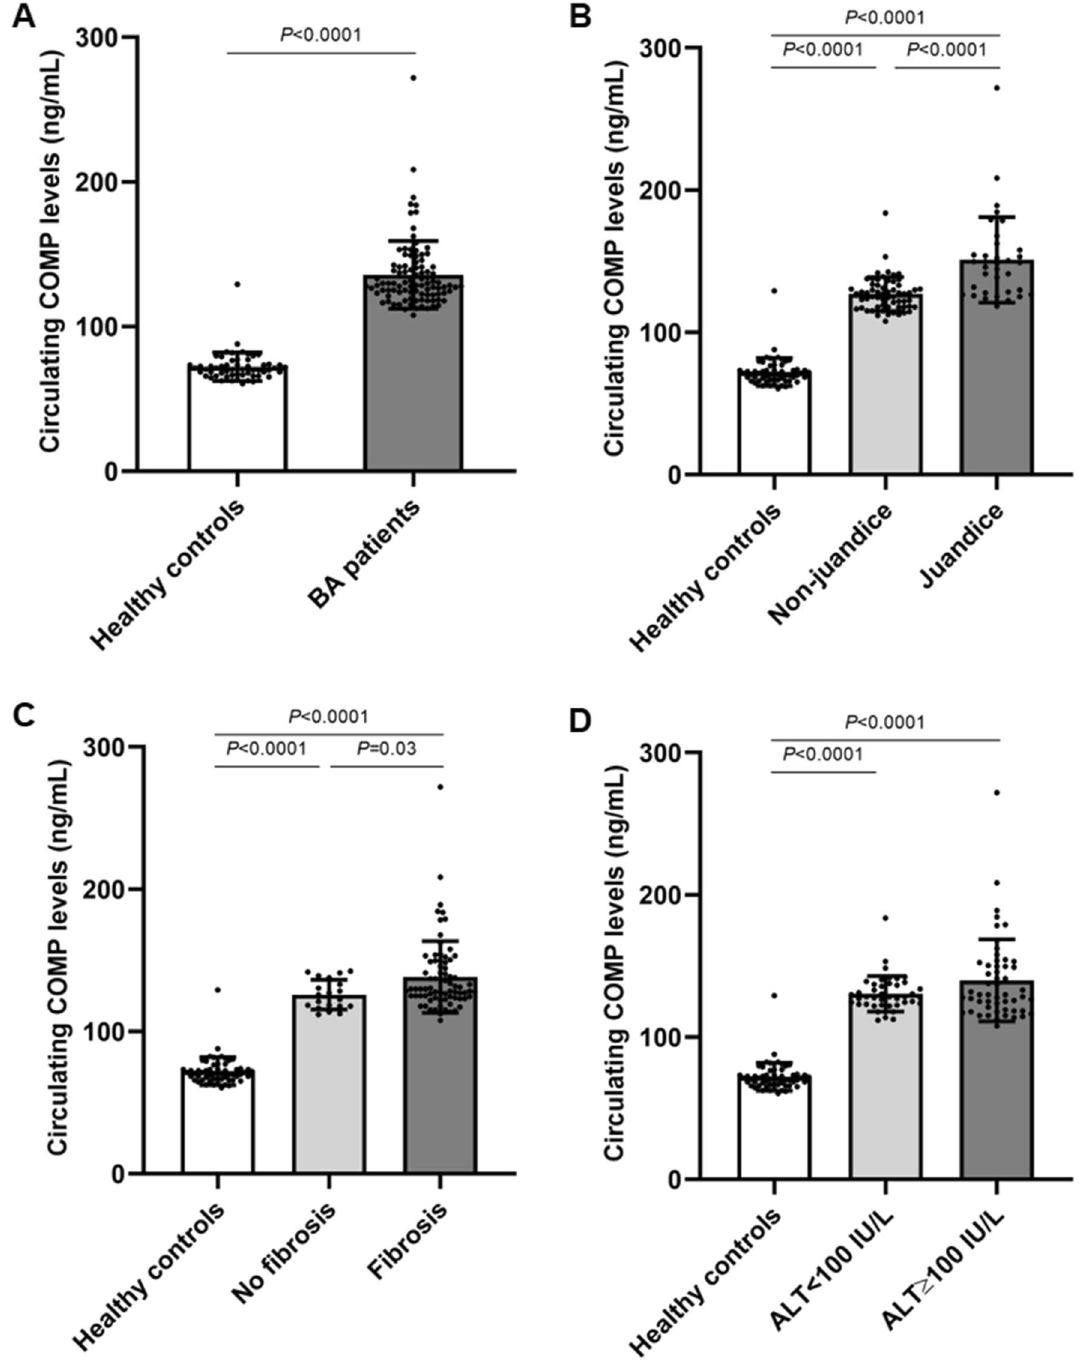
Figure 1. Circulating COMP levels in healthy controls and BA patients with different groups. ( A ) Healthy controls ( n = 56) and BA patients ( n = 96). ( B ) BA patients divided into non-jaundice (TB < 2 mg/dL, n = 61) and jaundice (TB ≥ 2 mg/dL, n = 35) groups. ( C ) BA patients classified into no fibrosis (< 7.1 kPa, n = 20) and fibrosis (≥ 7.1 kPa, n = 76) groups. ( D ) BA patients categorized into low- (< 100 IU/L, n = 46) and high ALT values (≥ 100 IU/L, n =